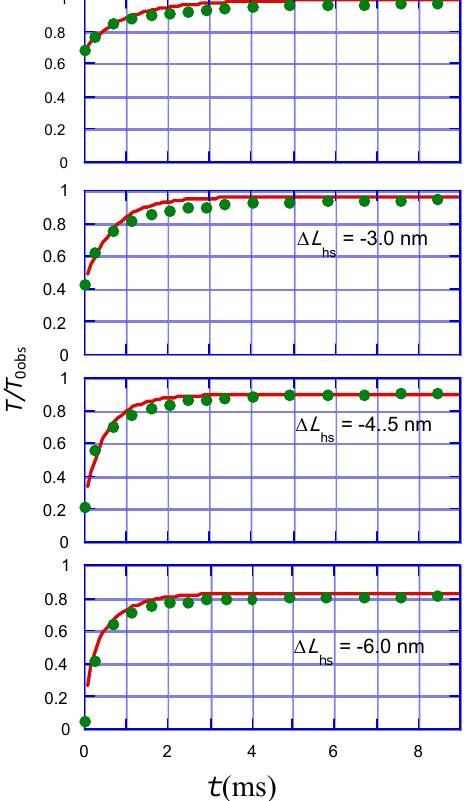
Figure 14. T / T as functions of time t for various length change steps  L 0obs isometric tension transient. The origin of t is set as the moment that Phase T1 finishes. Green circles: Experimental data cited from Figure 23 of Ford et al. [16]. Red lines: Values of / T calculated by using Equations 34, 35, 36 and the parameter values in Equation T 123a 0obs